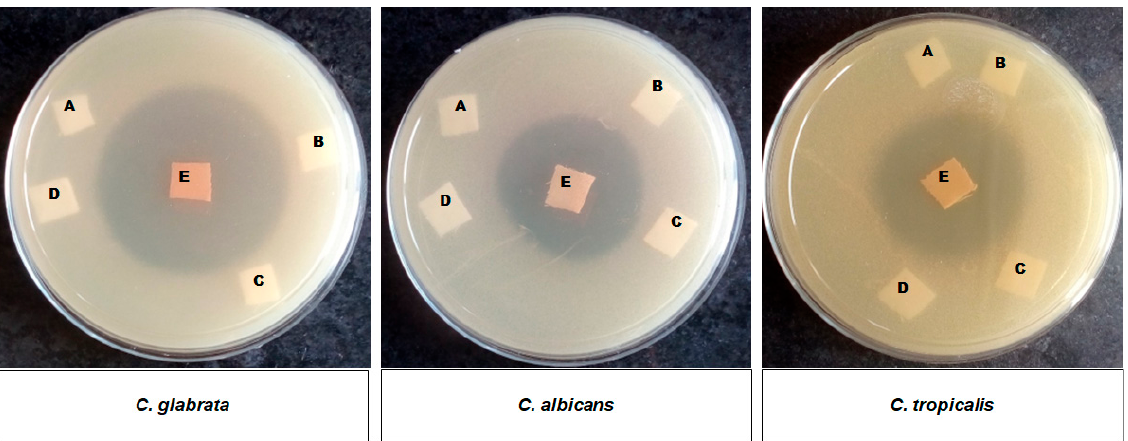
Figure 5. Agar diffusion assay of (1) C. glabrata (2) C. albicans and (3) C. tropicalis showing ZOI around the Se-coated-30 fabric E, where A, B, C and D represent controls: sodium selenite salt, guava extract, uncoated fabric and activated fabric samples, respectively.